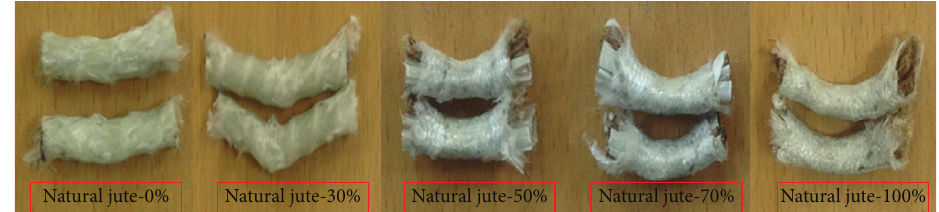
Figure 8: Fracture deformation of HGJFRP composite bar after shot beam tests.